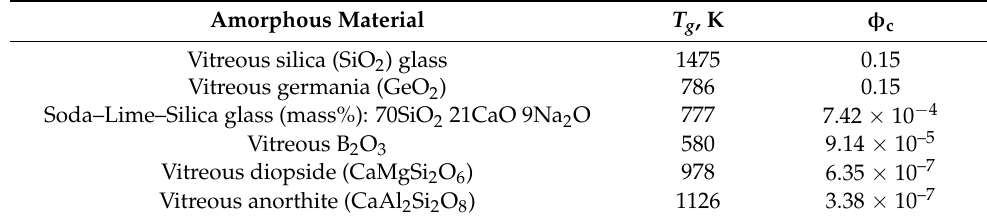
Table 2. Percolation